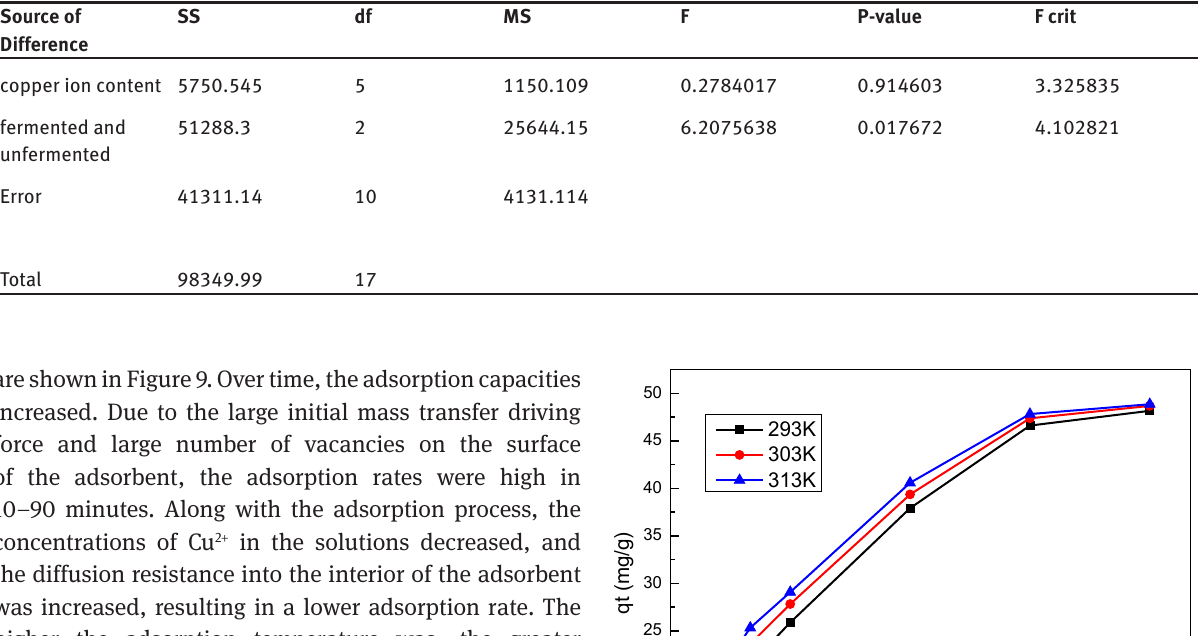
Table 1: variance analysis of the removal rate of copper ion by the fermented and unfermented Magnolia officinalis residues. Source of